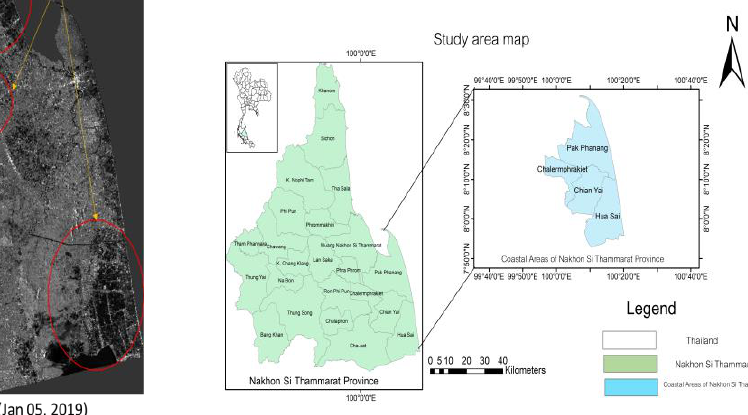
Figure 1. Study area